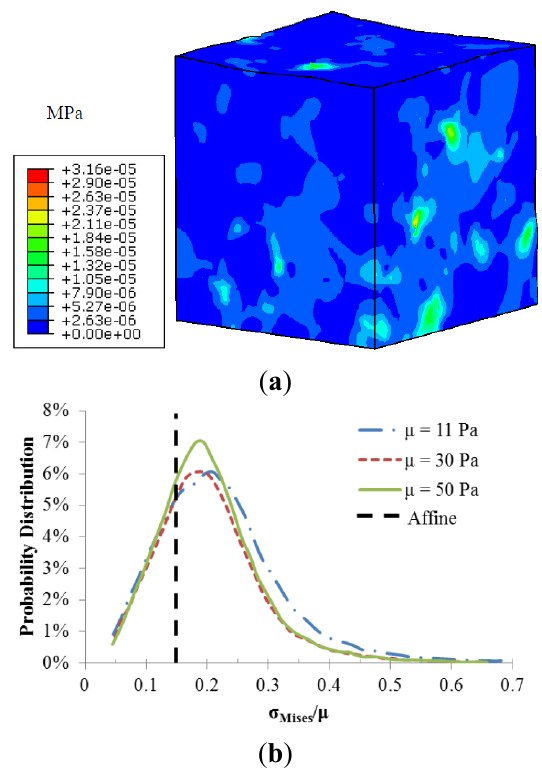
Figure 4. ( a ) Von-Mises stress distribution of the matrix with shear modulus of 11 Pa; ( b ) Probability distributions of normalized matrix stress.